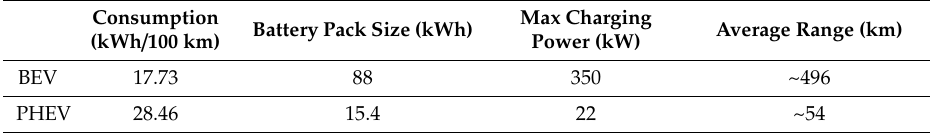
Table 7. Electric Vehicle Assumptions for Year 2030